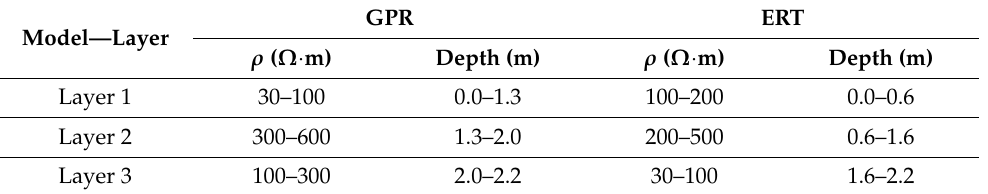
Table 1. Simplified resistivity model obtained from GPR and ERT resistivity sections.